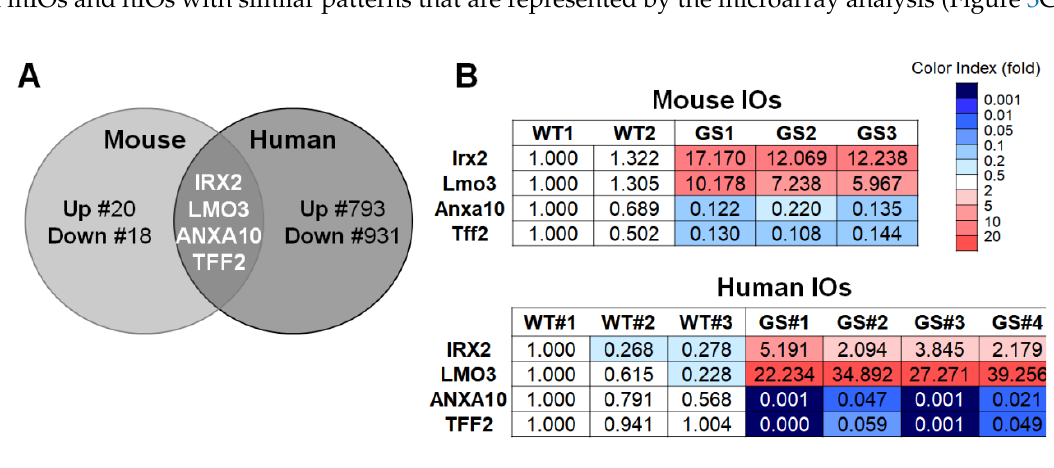
Figure 3. Identification and validation of commonly up-regulated or down-regulated factors based on the transcriptome analysis. ( A ) Venn diagram of the identification of commonly regulated factors between mIOs and hIOs. DEGs were selected on the basis of a >5-fold change (FC). Four factors (Iroquois homeobox 2; IRX2 , LIM domain only 3; LMO3 , AnnexinA10; ANXA10, and Trefoil factor 2; TFF2 ) were affiliated to the intersection. ( B ) Transcriptome analysis data of commonly regulated genes. ( C ) Quantitative Real-Time PCR (qRT-PCR) verification of commonly regulated genes,